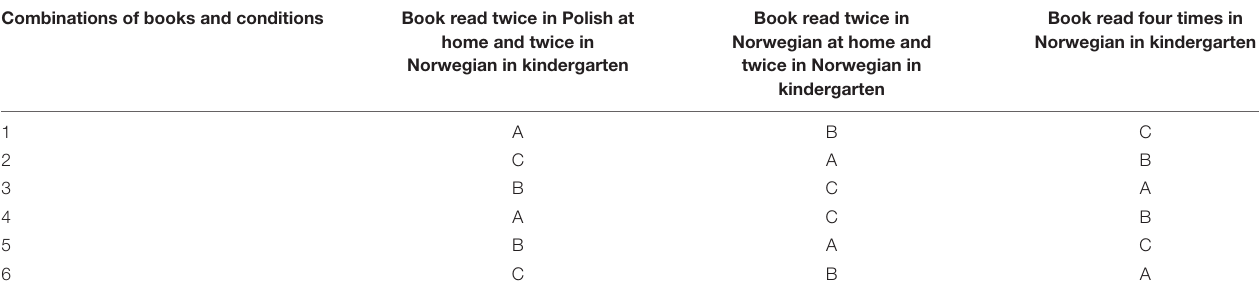
TABLE 1 | The six possible combinations of books and